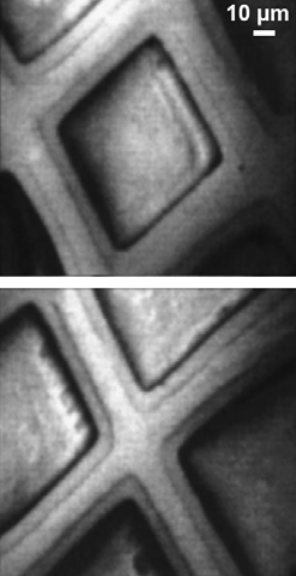
Figure 10. Images of a copper mesh obtained with approach (b) in Figure 7. Note the high lateral resolution. Data from [18].